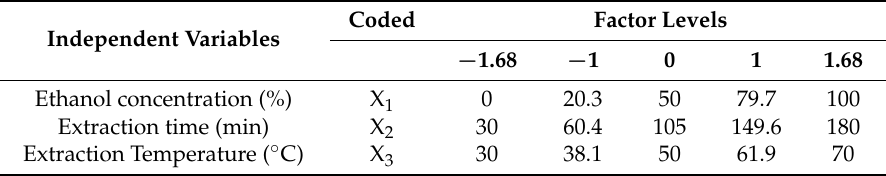
Table 1. Original and coded values of the process factors and CCD design